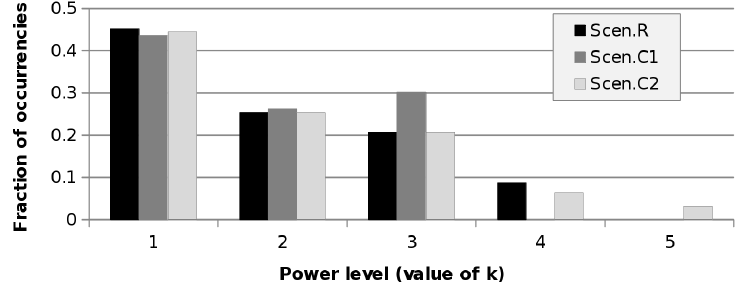
Figure 4. Occurrences of the power levels as a function of the test scenario for the case D =